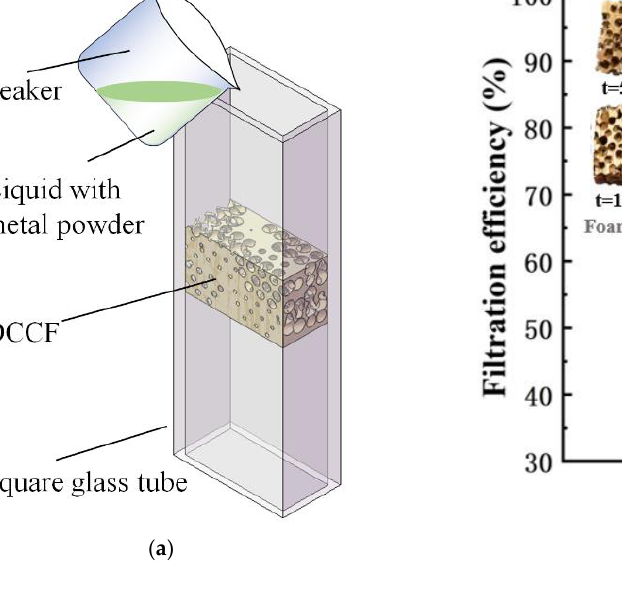
Figure 12. ( a ) Filtering experiment diagram of OCCF. ( b ) Filtration efficiency of OCCF with different filter thickness for different inclusion filtrating.